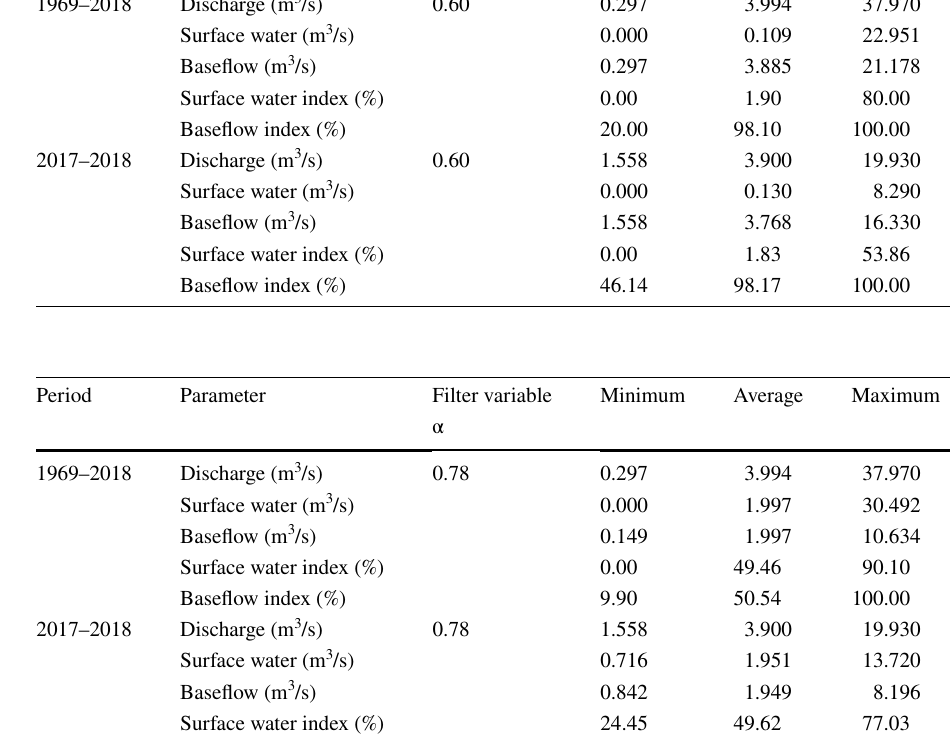
method—Lyne and Hollick algorithm